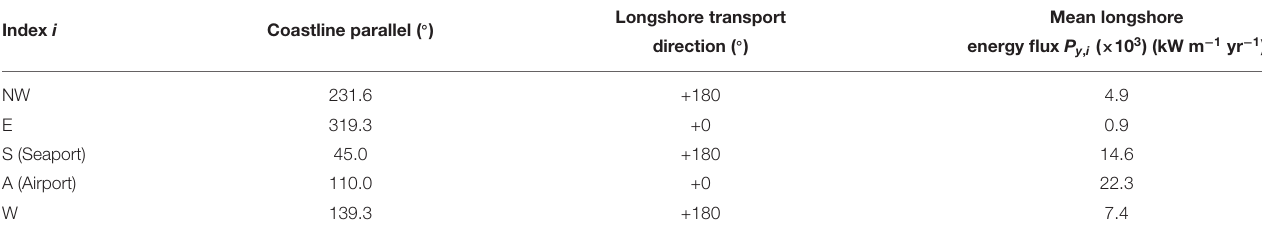
TABLE 2 | Beach orientation as well as longshore sediment transport directions and energy flux rates P y , i from the CERC-formulation ( Figures 5A , 7 , 8 ).